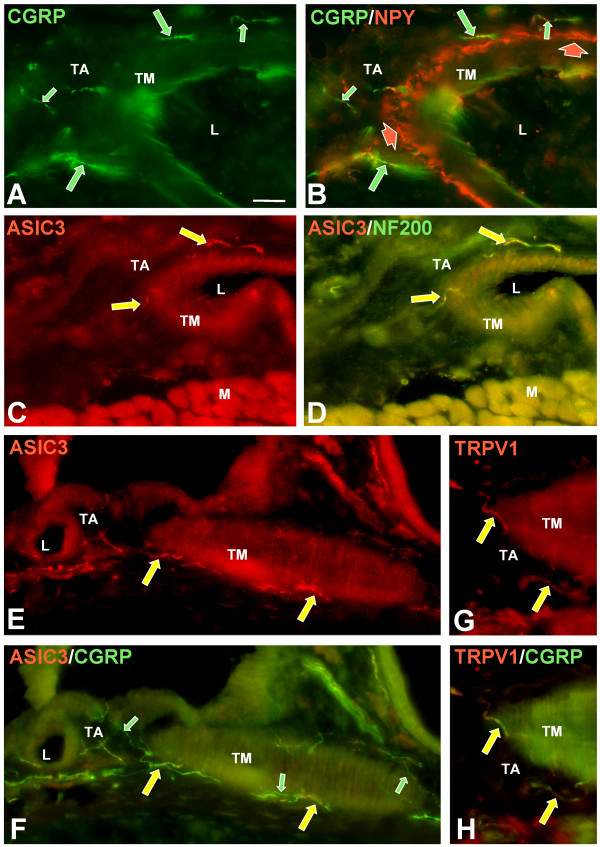
Double-label immunofluorescence of arterial innervation among muscles in the lateral plantar compartment of the rat hind paw. Red labeling is with secondary antibodies conjugated with Cy3, green with Cy2. The images in A and B are from a larger source artery and those in C-H are from smaller tributaries. L = arterial lumen, TA = tunica adventitia, TM = tunica media, M = skeletal muscle. Scale bar = 25 μm. A, B. Cross section of a larger artery with lumen (L) toward the right. Anti-CGRP (A) labeled sensory innervation that is located primarily in the tunica adventitia (green arrows). This CGRP-positive sensory innervation is supplied by axons that have thin calibers (small green arrows) and slightly thicker-calibers (large green arrows). Double labeling with anti-NPY (B) revealed sympathetic innervation concentrated at the border between the tunica media and tunica adventitia (red arrows). C, D. Cross section of an arteriole with lumen to the upper right, Muscle fibers (M) in cross section below. Double staining with anti-ASIC3 (C) and anti-NF200 (D) demonstrated that ASIC3 is expressed primarily on the slightly thicker caliber innervation that is NF200-positive (yellow arrows). E, F. Small arterioles viewed both in cross section (lumen labelled L) and on edge (oval structure labelled TM). Double labeling with anti-ASIC3 (E) and anti-CGRP (F) revealed that ASIC3 is coexpressed exclusively with CGRP, primarily on the thicker-caliber innervation (yellow arrows). The smaller-caliber CGRP innervation is usually ASIC3-negative (green arrows). G, H. Edge of an artery cross section; lumen is out of the picture to the right; tunica media (TM) and tunica adventitia (TA) are marked. Double labeling with anti-TRPV1 (E) and anti-CGRP (F) demonstrated that TRPV1 is also coexpressed on the larger caliber CGRP-positive innervation (yellow arrows).